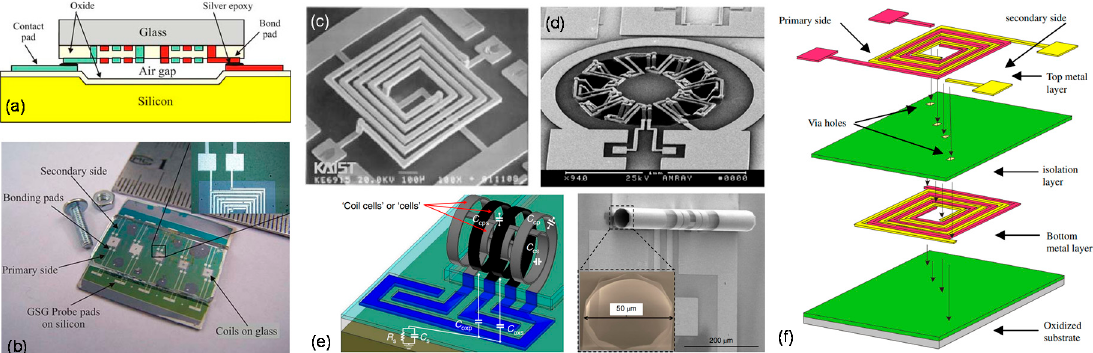
Figure 6. On-chip transformers enabled by MEMS processes and integration techniques: ( a ) Cross-sectional schematic view of a MEMS on-chip transformer using bulk micromachining and wafer bonding and ( b ) image of the fabricated device, reprinted with permission from [34]; ( c ) a surface micromachined MEMS on-chip transformer using thick photoresist process, reprinted with permission from [28]; ( d ) example of a toroidal on-chip transformer realized by bulk micromachining process, reprinted with permission from [32]; ( e ) surface micromachined, roll-up on-chip transformer, reprinted with permission from [76]; ( f ) stacked transformer structure isolated by insulating oxide layer, reprinted with permission from [77].